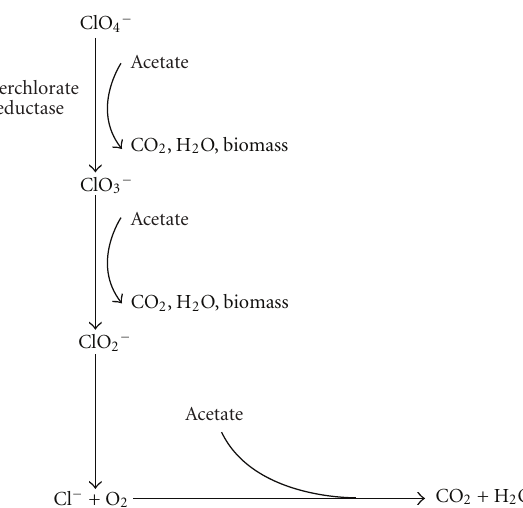
Figure 8: Biological transformation pathway for perchlorate (Adapted from [64,